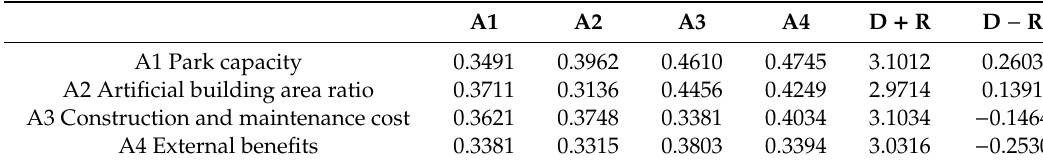
Table 3. DEMATEL results for the economic aspect.